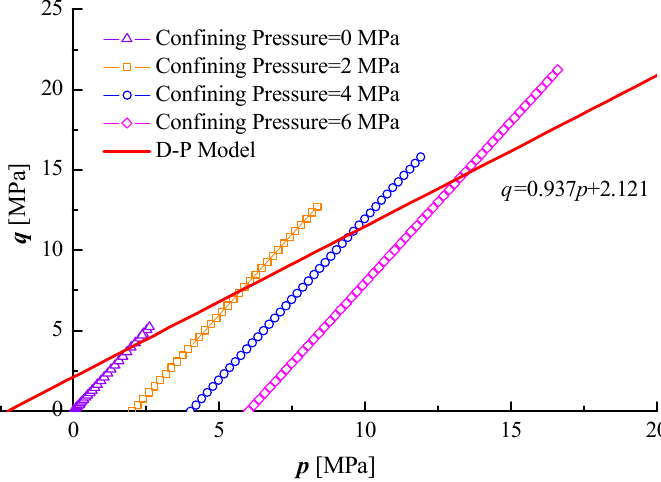
Figure 8. Critical strength test results for freezing coal specimens.